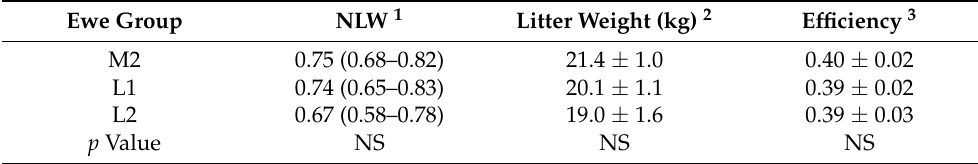
Table 5. The mean number of lambs weaned (NLW), litter weight (kg) and efficiency (ratio of total progeny litter weight to ewe breeding weight) per year for the first two years of breeding for ewes born (Table 2) to ewe lambs as singletons (L1) or as twins (L2). Values for average number of lambs weaned are back-transformed LS means and 95% confidence intervals, and values for litter weight and efficiency are LS means ±